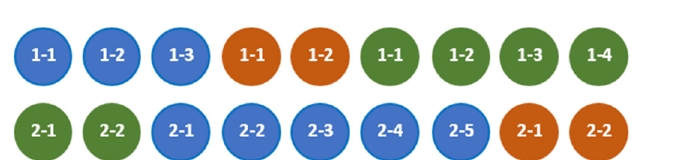
Figure 2. An example of two quasi-compatible aggregates.